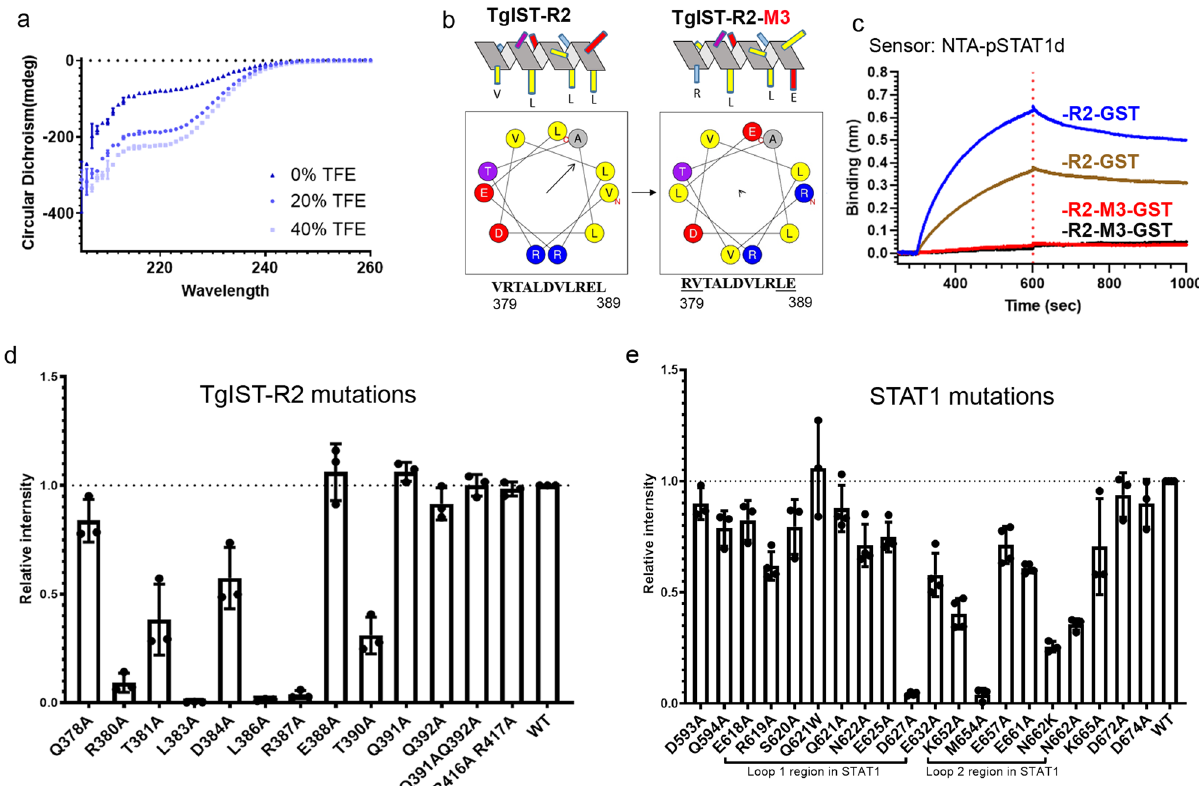
Fig. 6 TgIST adopts a helix conformation upon binding the STAT1 dimer. a Circular dichroism (CD) of TgIST-R2. Nickel af fi nity-puri fi ed TgIST-T2 was buffer exchanged into phosphate buffer (pH 7.8) and adjusted to a concentration of 100 µ g/ml. CD spectra were recorded in a 10 mm cuvette at 25 °C in the absence of tri fl uoroethanol (TFE), or in the presence of 20%, 40% TFE that induced secondary structure formation. Data presented as mean + s.d. from two independent experiments. b TgIST-R2 is predicted to form an amphipathic alpha-helical structure shown as a side projection at the top and a helical wheel at the bottom. The wild type repeat region is shown on the left and the mutant is on the right. Predictions are based on the HeliQuest server. Arrows within the helical wheel projection indicate the hydrophobic face and the length is proportional to the degree of hydrophobicity. c Measurement of the interaction between wild-type TgIST-R2 (R2-GST) and pSTAT1d vs. the charge altered TgIST-R2 mutant (R2-M3-GST) and pSTAT1d by BLI assay. Phosphorylated STAT1 dimer (pSTAT1d) was immobilized onto Ni-NTA biosensors, followed by incubating with R2-GST (100 or 50 nM, represented by blue and tan, respectively) or R2-M3-GST (100 or 50 nM, represented by red and black, respectively). d Nickel af fi nity puri fi cation of His-tagged TgIST-R2 wild type (WT) and various point mutants of TgIST-R2 was used to test copuri fi cation with the STAT1 locked dimer (STAT1cc). Eluted fractions were separated by SDS-PAGE gel then stained with Coomassie blue (see Supplementary Fig. 9a). The relative binding intensities were adjusted to the binding between wild-type TgIST-R2 and STAT1cc. Data presented as mean + s.d. from three independent experiments ( n = 3). e Nickel af fi nity puri fi cation of His- tagged TgIST-R2 and copuri fi cation of wild type (WT) and various mutants of STAT1 locked dimer (STAT1cc). Polar and charged amino acids in and around two loop regions were mutated in STAT1cc. Quanti fi cation was performed as in ( d ). Data presented as mean ± s.d. from three independent experiments ( n = 3). Source data are provided in the Source Data fi